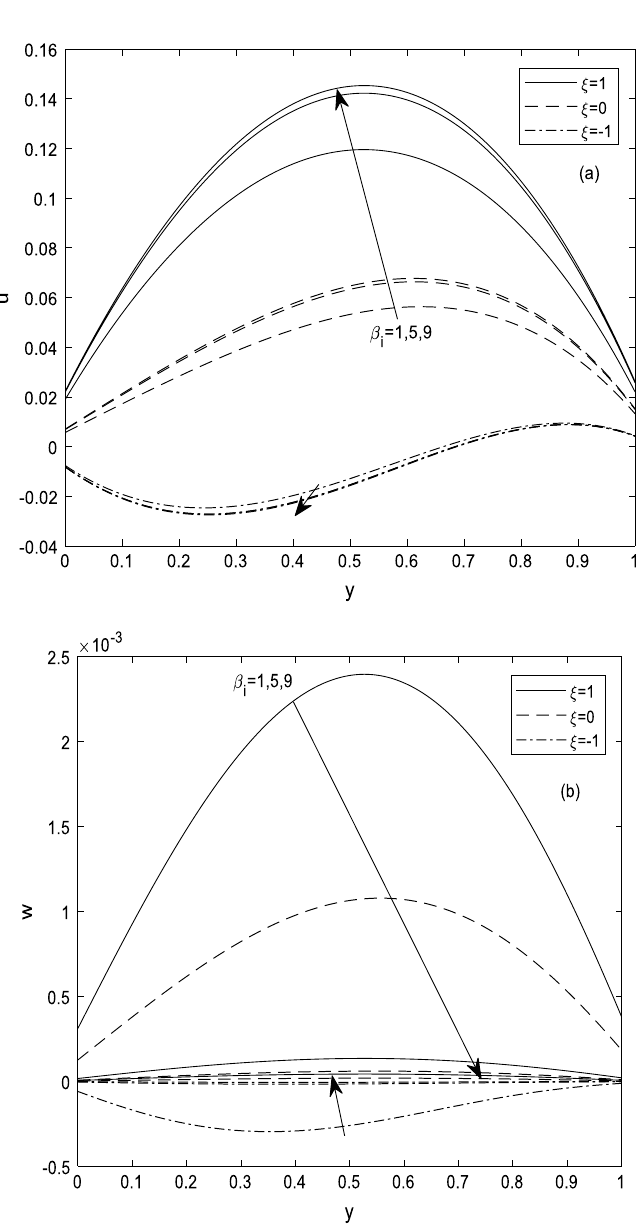
v Kn = 0.05, M = 2,ln = 1.667, S = 0.5, β h = 0.10 and Pr = 0.71 . b Ion-slip parameter ( β i ) on the main flow and induced velocity profiles, for β